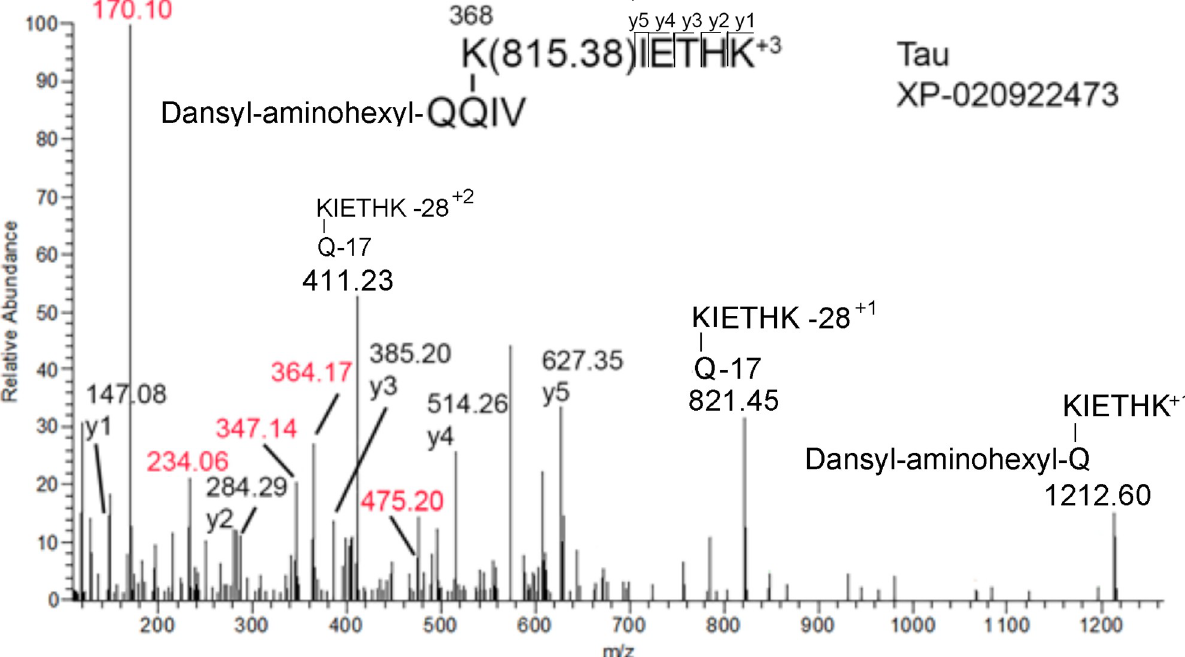
Fig 4. MS/MS spectrum of the dansyl-aminohexyl-QQIV adduct at K368 of Tau. This peptide was found in a gel slice from MAP-rich tubulin Sus scrofa that had been treated with dansyl-aminohexyl-QQIV and human transglutaminase. A complete y-ion sequence was obtained from the triply- charged parent ion, at 524.28 m/z. Characteristic ions from the fragmentation of dansyl-aminohexyl QQIV were observed at 170.10, 234.06, 347.14, 364.17, and 475.20 (shown in red) [35]. Linkage between the peptide lysine and the adduct glutamine occurs at both glutamines in Q 1 Q 2 IV. The ion at 475.20 is evidence for linkage to Q 2 . The ion at 1212.60 is evidence for linkage to Q 1 . https://doi.org/10.1371/journal.pone.0254450.g004 PLOS ONE | https://doi.org/10.1371/journal.pone.0254450 July 9,